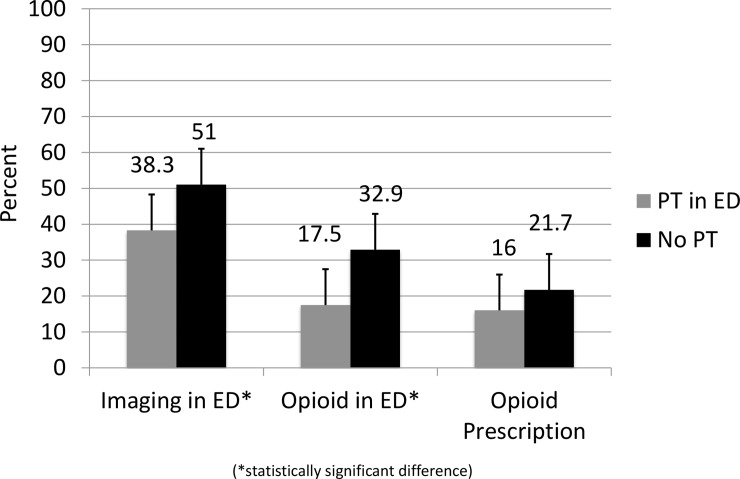
Imaging and opioid administration rates.